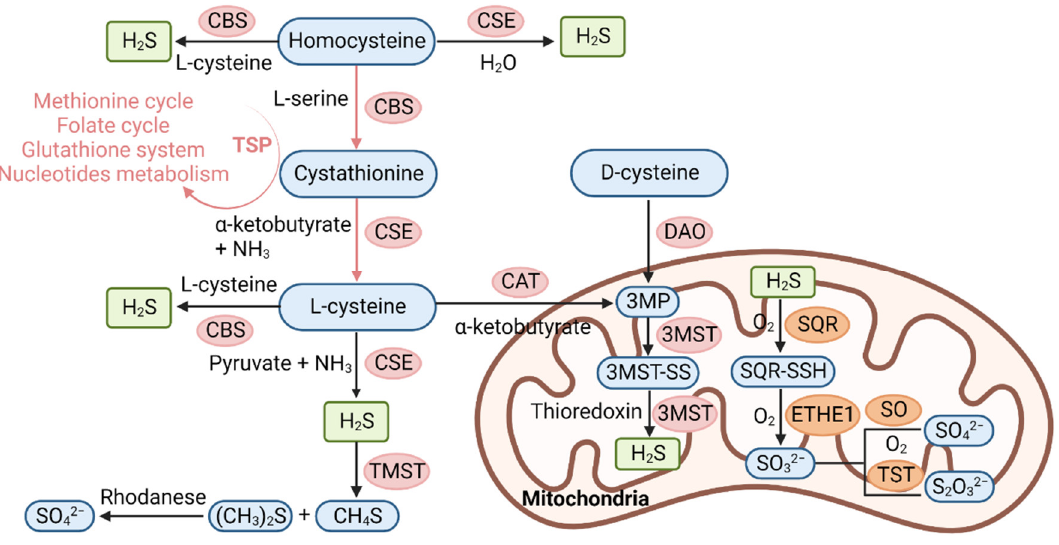
Figure 1. Cellular biosynthesis and oxidation of H 2 S.